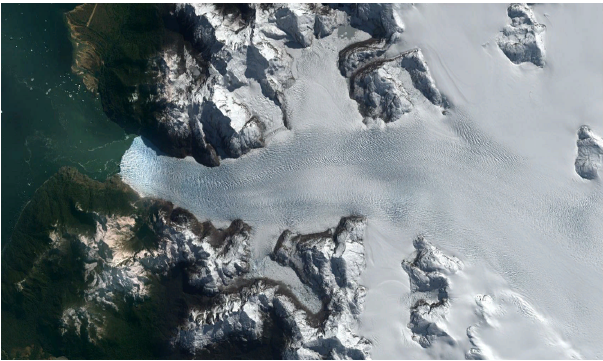
Figure 2. San Rafael Glacier, Northern Patagonian Ice Field